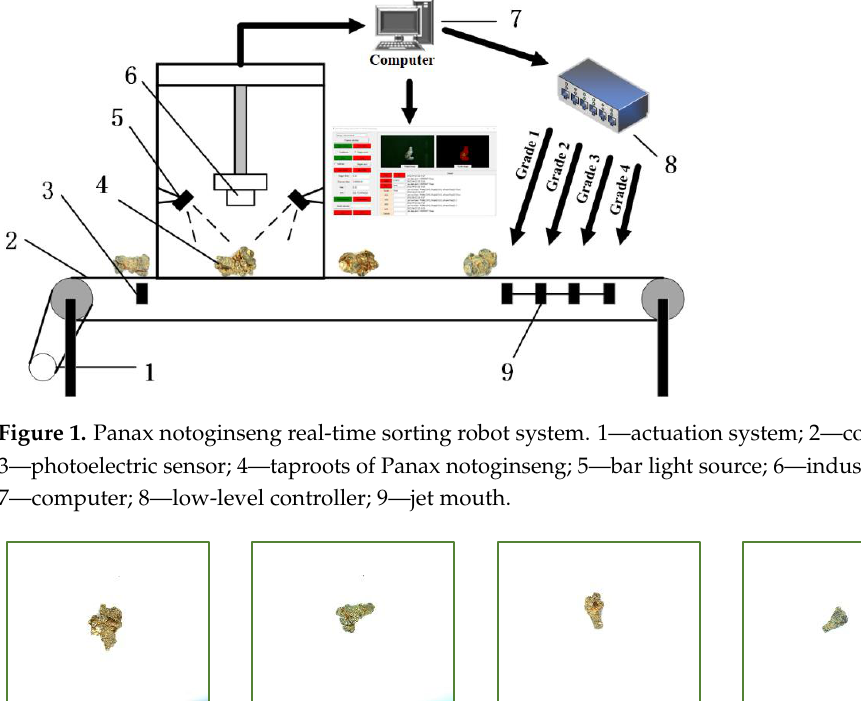
Flip Pan Rotate Noise Figure 3. Schematic diagram of image enhancement in the dataset. 2.3. Panax Notoginseng Quick Identification and Sorting Method 2.3.1. Introduction to Semantic Segmentation Models U-Net was a relatively early fully convolutional neural network used in semantic segmentation [31]. It is divided into upsampling and downsampling stages. There was no pooling layer in the network structure, only convolutional layers and fully connected lay- ers. Deep and shallow features solve pixel localization and classification problems. The PSPNet network model mainly adopts an average pooling layer with different step sizes and different pooling sizes, and then fully connects the pooled results, thereby increasing the receptive field of the segmentation layer and merging deep information with shallow information [32]. Finally, the fused feature layer with overall information is obtained. The DeepLabv3+ network was the most commonly used network in semantic seg- mentation due to its high segmentation accuracy and superior performance [33]. It con- sists of an encoder and a decoder. The encoder consists of a backbone feature extraction network and an ASPP module. The decoding part mainly extracts the shallow features of the backbone feature network, and then fuses the extracted shallow features with high- level semantic features to improve the accuracy of the segmentation model. 2.3.2. Improved Panax Notoginseng Taproot DeepLabv3+ Grading Model In this study, DeepLabv3+ was used as the segmentation model of the taproots of Panax notoginseng at different grades, and Xception was used as the backbone feature